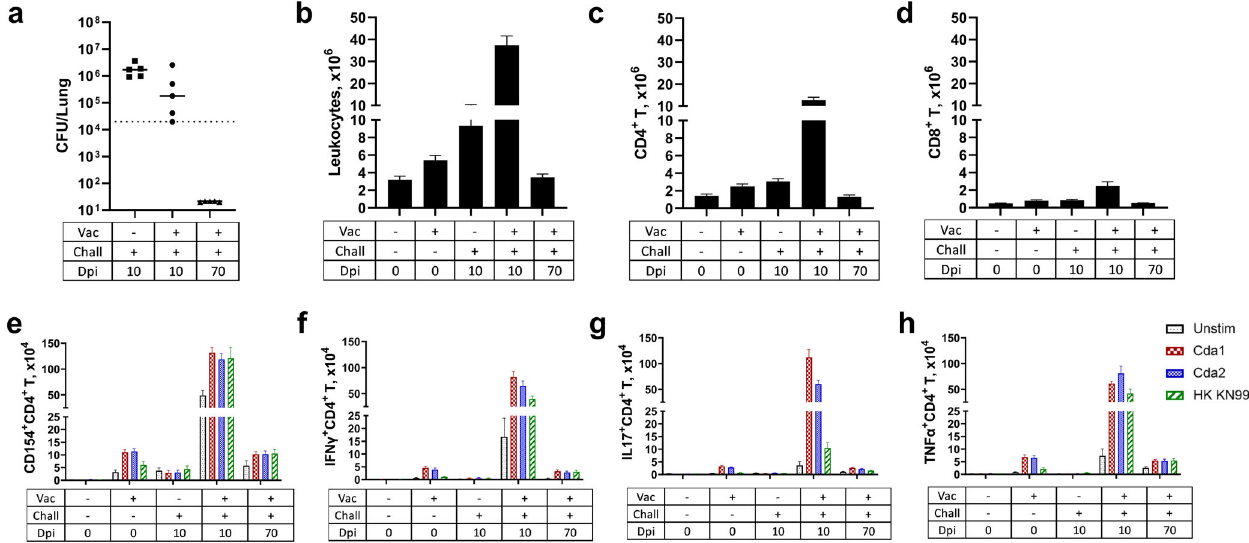
Fig. 6 Analysis of lung CFU, leukocytes, and ex vivo antigen-stimulated Th intracellular cytokine production following GP-Cda1/Cda2 vaccination and/or infection. BALB/c mice were vaccinated subcutaneously thrice at biweekly intervals with GP-Cda1/Cda2. Two weeks after the last boost, the mice received a pulmonary challenge with C. neoformans . Mice were euthanized at 0 dpi (uninfected), 10 dpi, or 70 dpi. Controls included unvaccinated mice euthanized at 0 dpi or 10 dpi. Lungs were harvested and single-cell suspensions were prepared. a CFU/ lung were determined. b Leukocytes at the interface of a 67 and 40% Percoll gradient were collected and counted. c – h Leukocytes were cultured in complete media supplemented with amphotericin B and stimulated with indicated antigens or left unstimulated (Unstim) for 18 h. Then the cells were collected, stained, and analyzed by polychromatic FACS, as described in Methods. c , d The numbers of CD4 + T and CD8 + T cells were calculated by multiplying the percentage of each population times the total leukocyte count. e – h The numbers of CD4 + T cells expressing the activation marker CD154, or producing the intracellular cytokines IFN γ , IL-17, and TNF α following ex vivo stimulation. Each group had fi ve mice. In Fig. 6a, the bar represents the median of individual lung CFUs, and the dotted line represents the inoculum dosage for a challenge (2 × 10 4 Cryptococcus ). In Fig. 6b – h, data are presented as mean ± SEM. Vac vaccinated with GP-Cda1/Cda2, Chall challenge with C. neoformans , Dpi days post infection, HK heat killed. Statistical comparisons between groups are shown in Supplementary Fig.